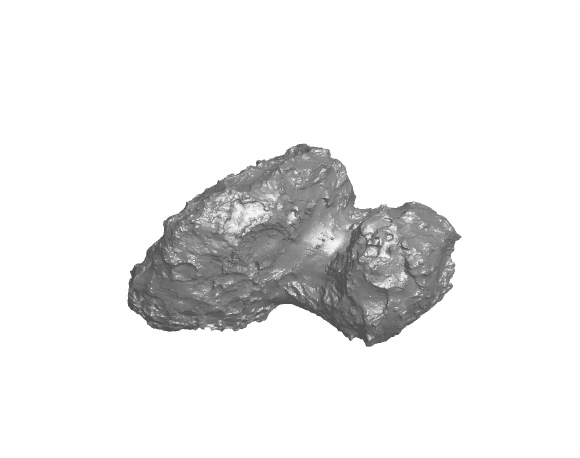
Figure 1 Rendering of comet Churyumov-Gershmenko based on a 4 million plate Digital Shape